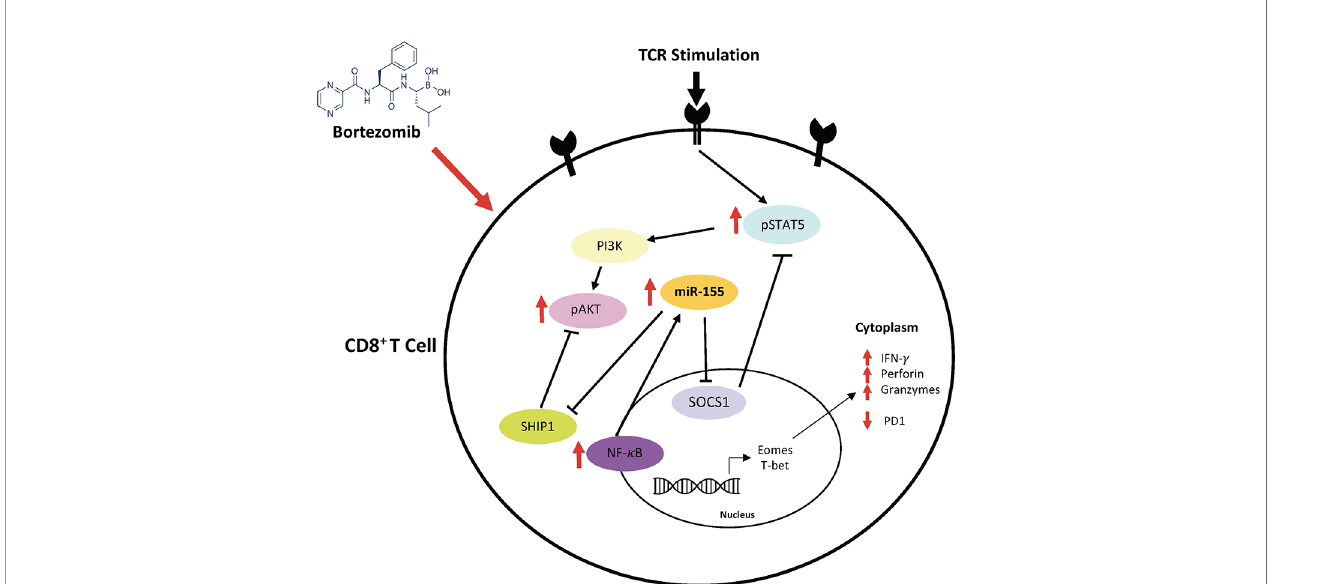
FIGURE 11 | Bortezomib-mediated miR-155 and NF- k B signaling crosstalk to increase CD8 + T cell effector function. Bortezomib enhances crosstalk between the miR-155 – SOCS1/SHIP1 – T-bet – PD-1 axis and NF- k B signaling in CD8 + T cells. Bortezomib treatment increases NF- k B activity and miR-155 expression, thereby causing a decrease in its inhibitory targets SHIP1 and SOCS1. The inhibition of these targets in turn lead to decreased PD-1-mediated exhaustion and increased expression of effector molecules in CD8 + T